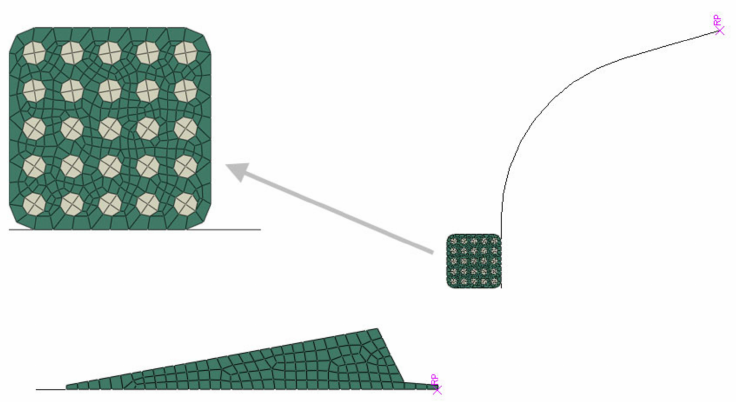
Figure 7. FE mesh of the